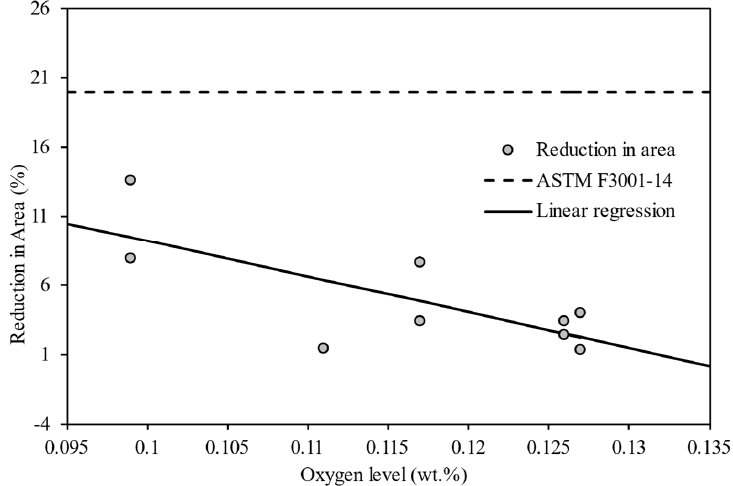
Figure 10. Reduction in area of the tensile tested samples against oxygen level of Ti6Al4V powder. The dashed line shows the value provided by ASTM F3001-14 [23]; the solid line indicates the linear regression result.